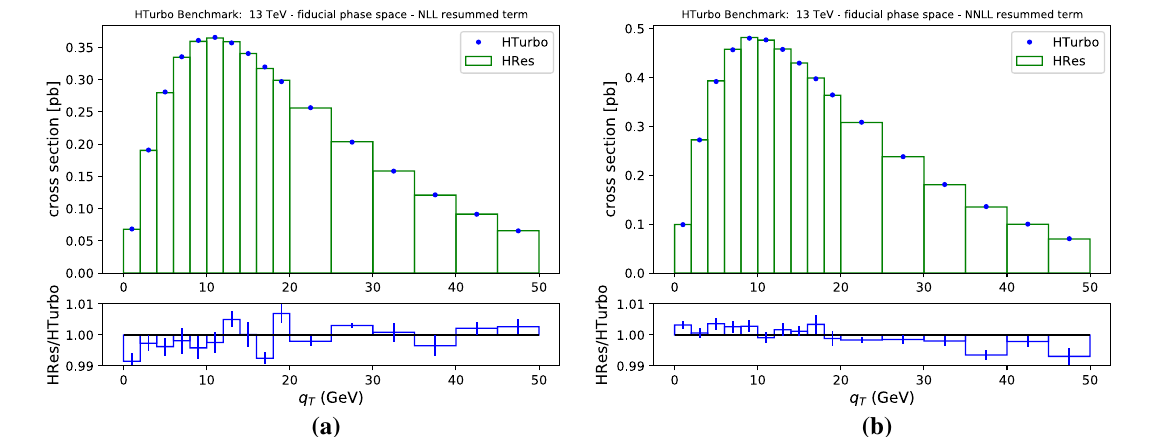
Fig. 4 Comparison of full-photon phase space differential cross sec- NNLL ( b ) accuracy. The top panels show absolute cross sections, and √ s = 13 TeV. Resummed tions computed with HRes and HTurbo at the bottom panels show ratios of HTurbo to HRes component of the transverse momentum distribution at NLL ( a ) and